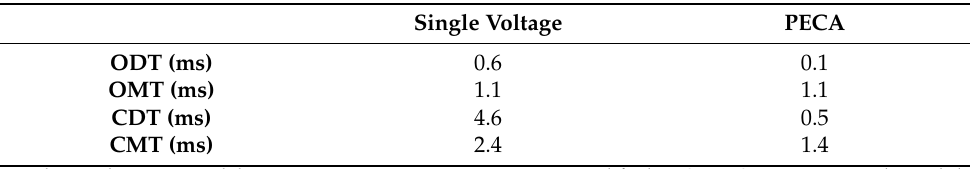
Table 1. Dynamic characteristics of the HSV in the two driven strategy.